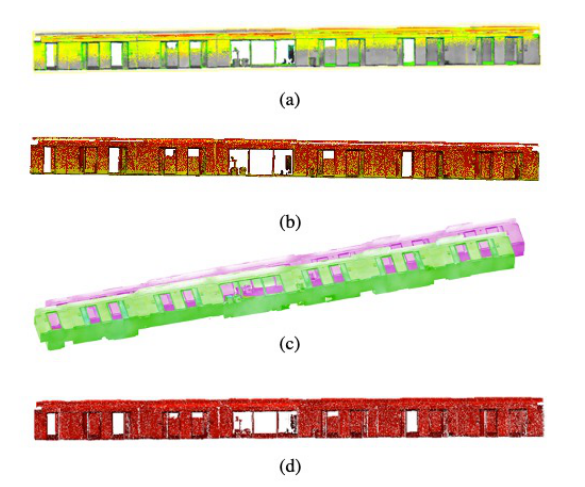
Figure 6. The hallway environment. (a) is our method. (b)is the result of ICP. (c) is the result of NDT. (d) is the result of Go-ICP.